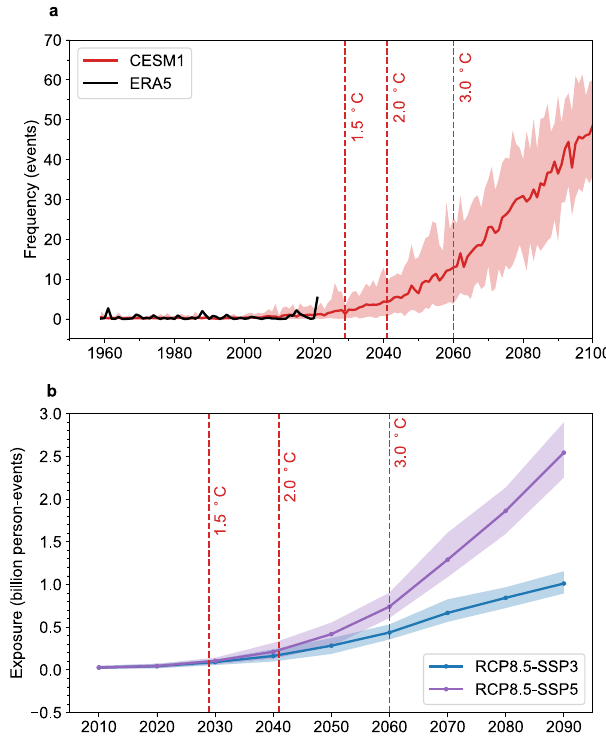
Fig. 6 | The frequency of 2021-like heatwaves and population exposure to heatwaves.a Theheatwavefrequency(unit:events)ofERA5reanalysis(black)and CESM1 historical and RCP8.5 simulations (red) area-weighted averaged over Wes- tern North America (WNA). b Population exposure to heatwaves across the WNA throughthe21stcenturyintheintegratedscenario:RCP8.5-SSP3withrapidgrowth in greenhouse gas emissions and low growth in population (blue, unit: billion person-events), RCP8.5-SSP5 with rapid growth in greenhouse gas emissions and higher growth in population (purple). The 1.5°C, 2°C, and 3°C global warming levels are reached in 2029, 2041, and 2060,